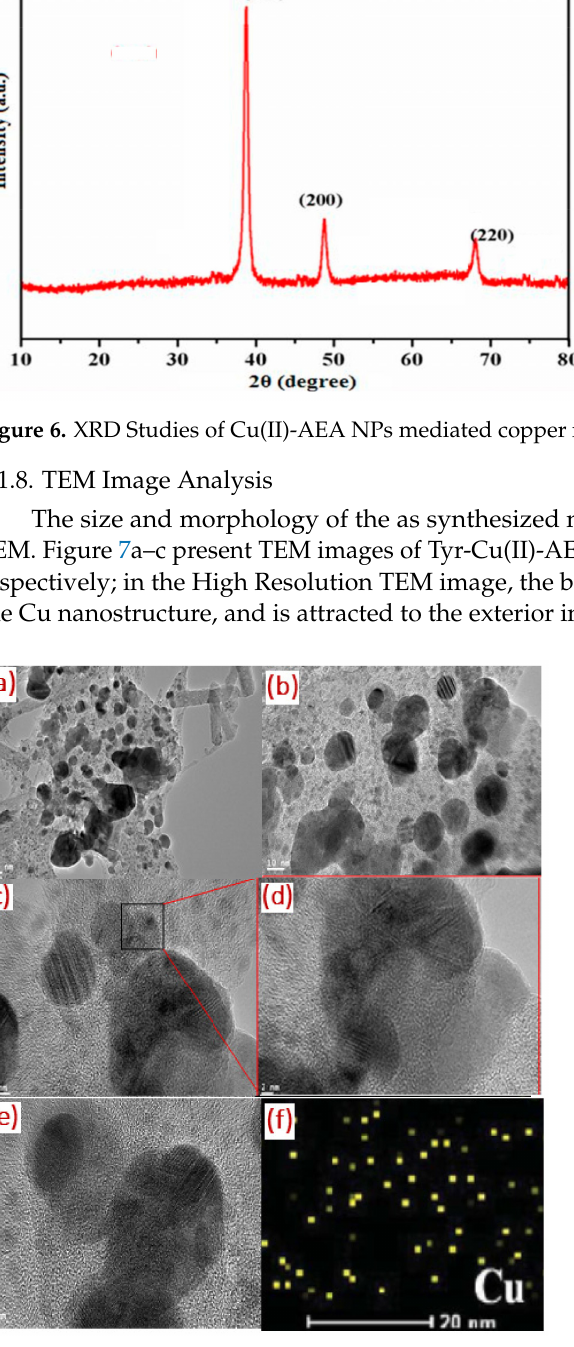
Figure 7. TEM image of Tyr-Cu(II)-AEEA NPs at ( a ) 20 nm, ( b ) 10 nm, ( c ) 5 nm, ( d ) HRTEM image, ( e ) lattice fringes of Cu(II)NPs, along with elemental maps of ( f ) Cu k α